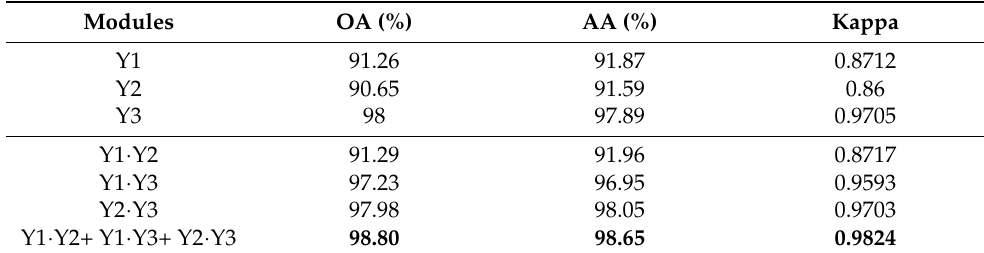
Table 6. The OA (%), AA (%), and Kappa coefficient for ablation experiments.